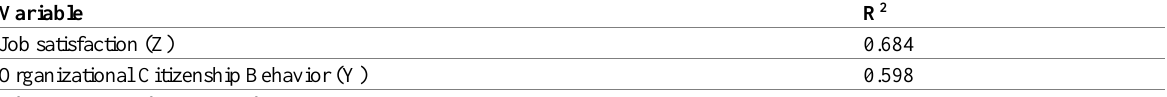
Table 5: Goodness of Fit Model